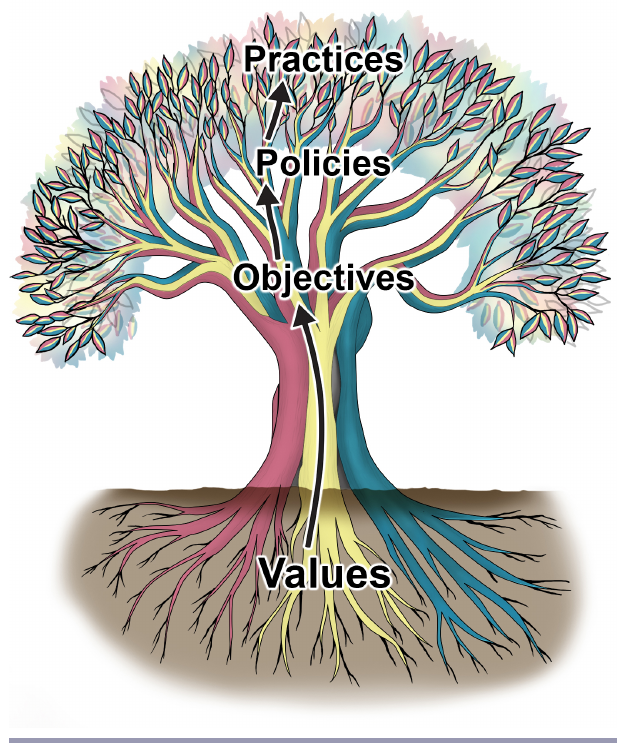
Fig. 2 . Representation of values-led environmental approaches, with each level building from those below. Values (roots of the tree) that connect people to place at a given scale form the foundation of the approach but are often not obvious to outside observers. These values combined inform the rest of the approach, supporting environmental objectives, which in turn support specific policies, which in turn guide individual practices. All aspects of the approach are mutually supportive; institutions that set and enforce objectives and policies link values and actual practices in the same way that branches link roots to leaves in a tree. The approach also evolves through time; just as growth of leaves supports growth of the rest of the tree, including its roots, and vice versa, so too do evolving practices drive changes in overall management, including guiding values, and vice